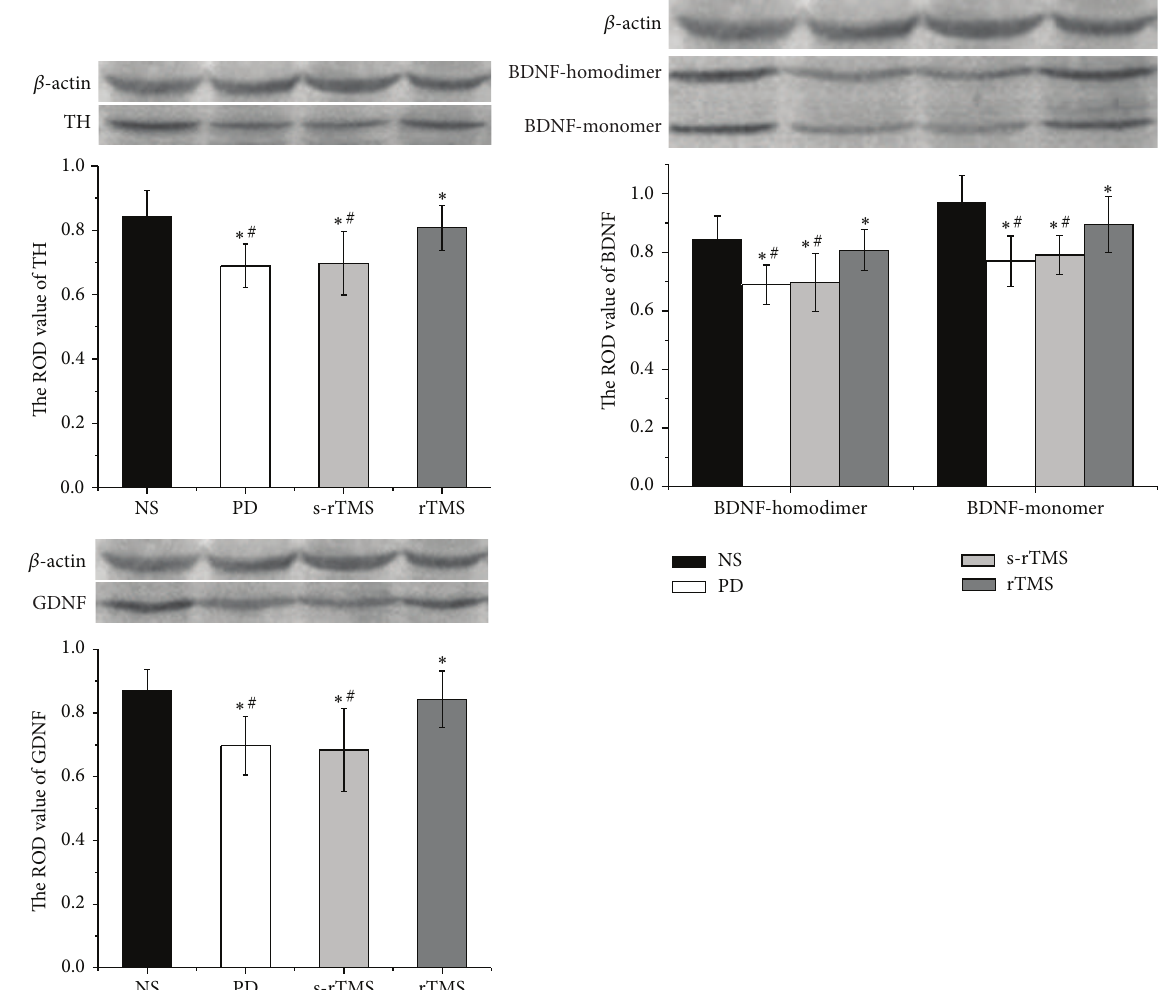
Figure 6: The effect of low-frequency rTMS on the expression of TH, BDNF, and GDNF as illustrated by western blot. ∗ Significantly different from NS group, 𝑃 < 0.05 ; # significantly different from rTMS group, 𝑃 < 0.05